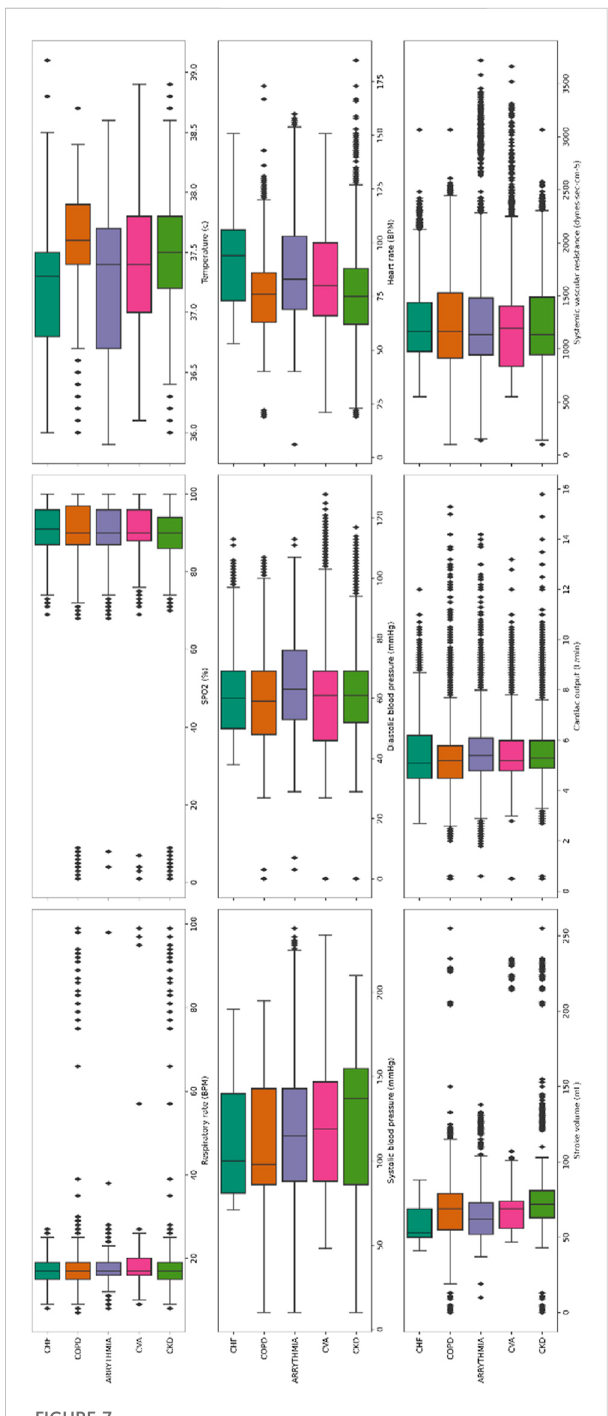
FIGURE 7 Segmentation of “ High ” or “ Urgent ” alerts in each physiological parameter in groups of patients based on the diagnosis on admission. 3,881 readings in patients with congestive heart failure (CHF, n = 24); 3,976 readings in patients with cerebrovascular accident (CVA, n = 29); 4,844 readings in patientswith chronicobstructivepulmonarydisease(COPD, n =39); 5,258 readings in patients with chronic kidney disease (CKD, n = 53); 9,727 patients with arrhythmias ( n = 67). The boxes in the current fi gure, represent the inter-quartile range (IQR, between percentile 25 and 75). The line in the middle is the median value. The whiskers are 1.5* IQR for both sides. The diamond in each subplot is the